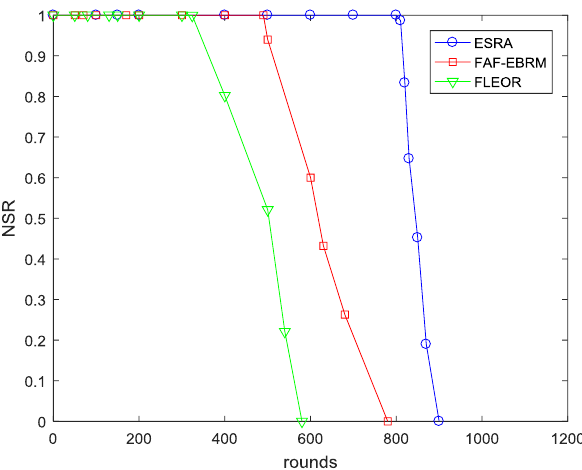
Figure 11. The NSR comparisons with varying rounds.